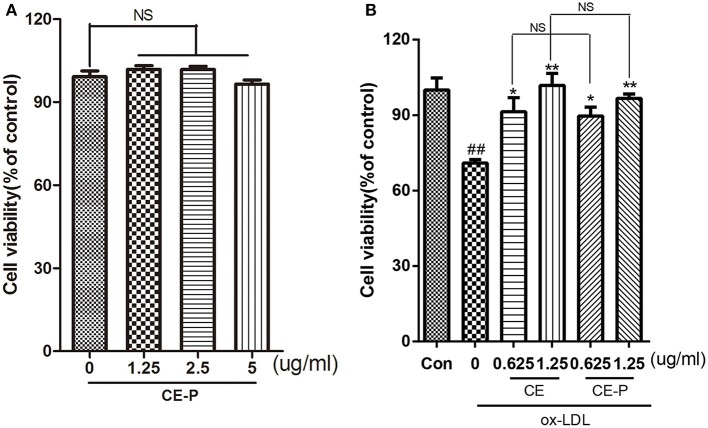
CE-P protects ox-LDL-induced endothelial cell injury. (A) To evaluated the cytotoxicity of CE-P, HUVECs were treated with CE-P alone (1.25, 2.5, 5 μg/mL) for 24 h and then the cell viability was measured by MTT assay. (B) HUVECs were pretreated with CE or CE-P (0.625, 1.25 μg/mL) for 8 h, then were incubated with or without ox-LDL for another 24 h and finally cell viability was assayed by MTT. The data are expressed as means ± SD. from three independent experiments. ##P < 0.01 vs. control group, *P < 0.05, **P < 0.01 versus ox-LDL treatment group. NS is no significance.